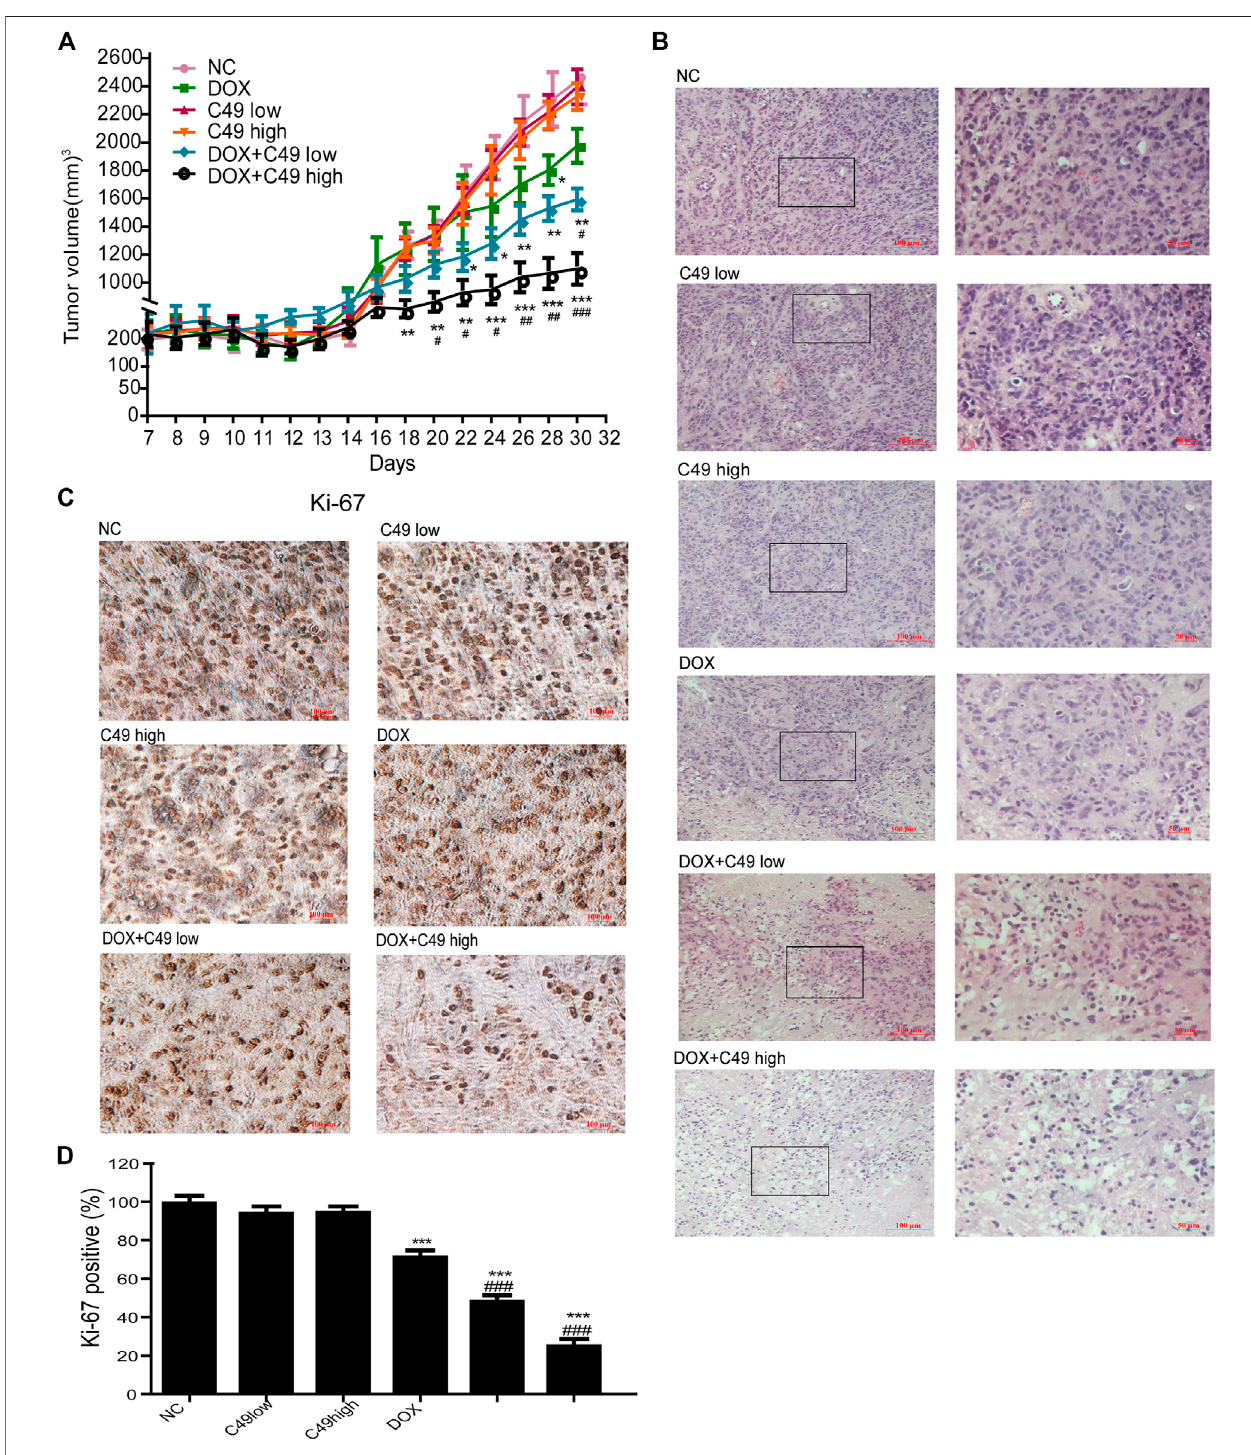
FIGURE 7 | C49 combined with DOX increased antitumor activity in MCF-7/DOX bearing nude mice. (A) Tumor volume in each group measured once every two days during drug treatment. Each bar represents mean ± SEM. Signi fi cant differences between control and DOX and/or C49 drug treatment group were indicated by * p < 0.05, ** p < 0.01 and *** p < 0.001. Signi fi cant differences between DOX treatment group and combination treatment group were indicated by # p < 0.05, ## p < 0.01 and ### p < 0.001. (B) H&E staining showed the necrosis of the tumor xenografts. (C) Ki-67 immunostaining showed the proliferation of tumor xenografts. (D) Quantitative analysis of Ki-67 immunostaining assay.